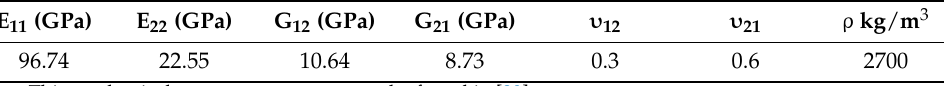
Figure 3. The geometrical model of the DCLCM. Table 1. Physical and mechanical properties of the Table 2. The parameters ’ specific values of the DCLCM model used for acoustical analysis.